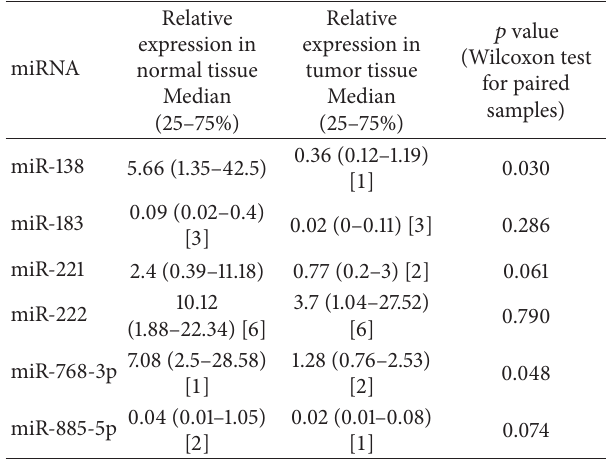
Table 4: Relative expression of miRNAs in normal and tumor samples of patients with